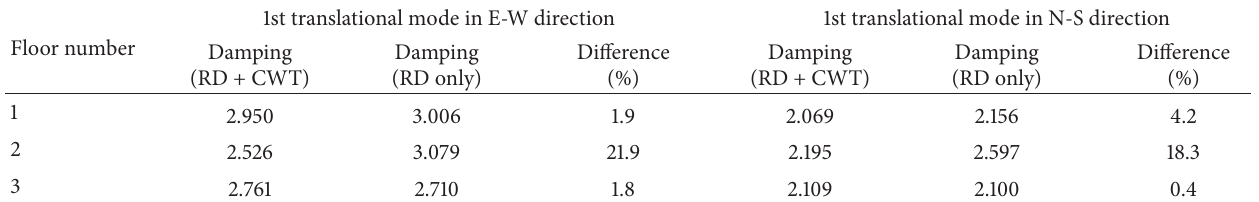
Table 4: Comparison of the damping ratios estimated using the two